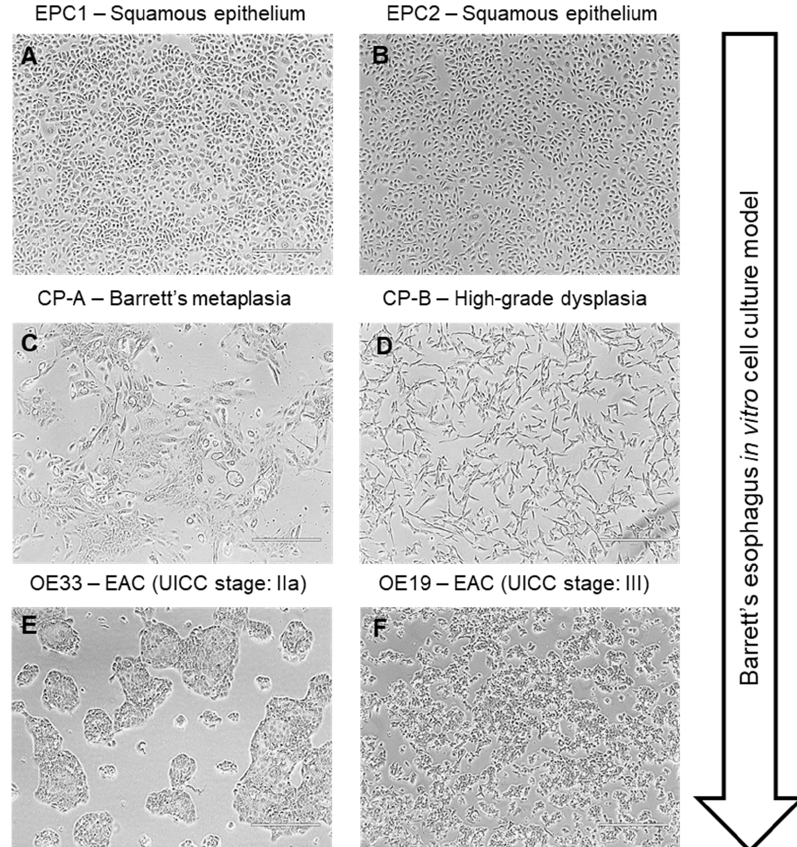
Figure 1 . The Barrett’s in vitro cell culture model consistent of the two squamous epithelium cell lines EPC1 ( A ) and EPC2 ( B ), the metaplastic cell line CP-A ( C ), the high-grade dysplastic cell line CP-B ( D ), and the two EAC cell lines OE33 ( E ) and OE19 ( F